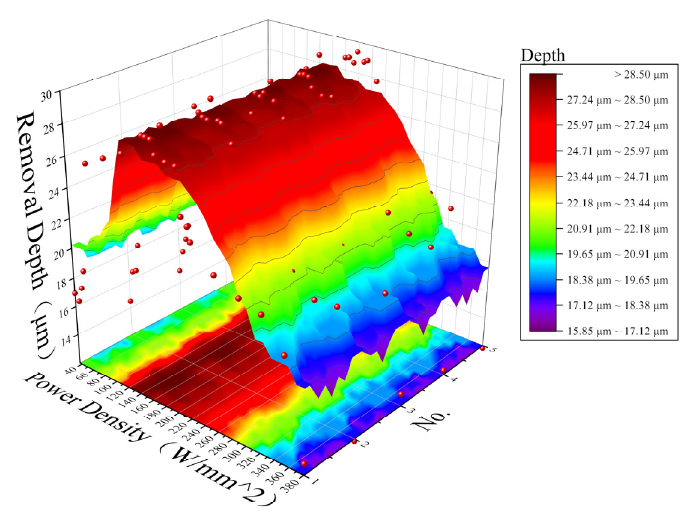
Figure 7. The removal depth varied with the power density.